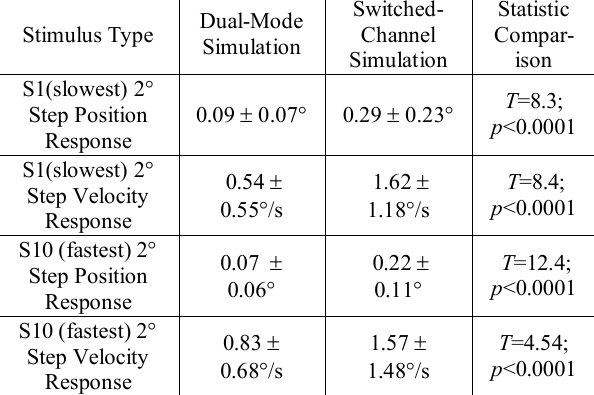
Table 3: Average error with one standard deviation for the entire response for the dual-mode and switched-channel simulations when input was reduced from 4  to 2  and compared to a 2  experimental responses. A student t-test was used for statistical comparision